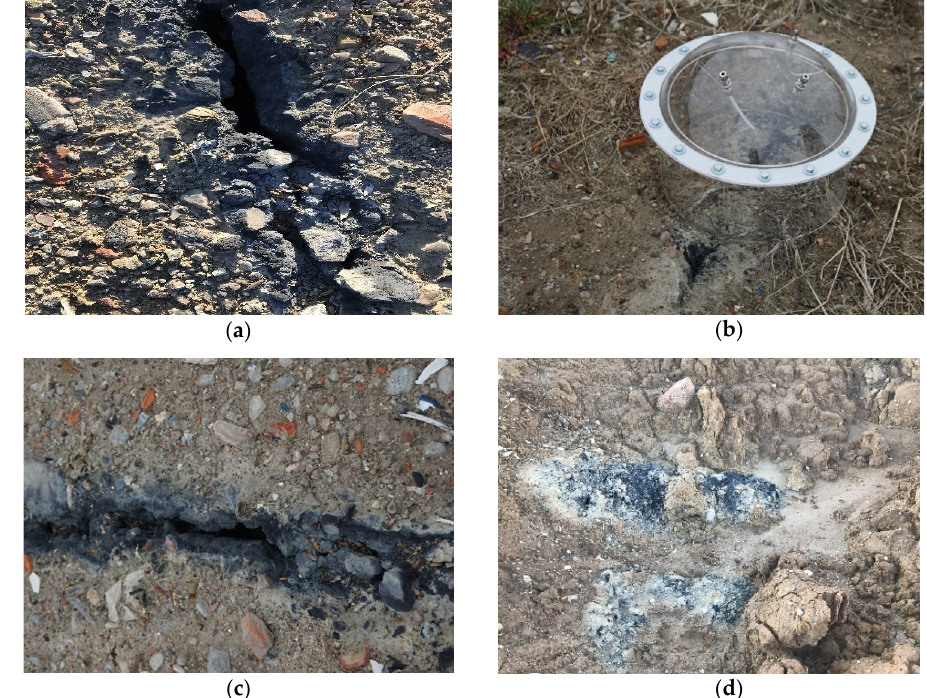
Figure 1. Distinctive sites in the study area indicative of significant degradation ( a , b —photographs taken in 2019; c , d —photographs taken in 2020).